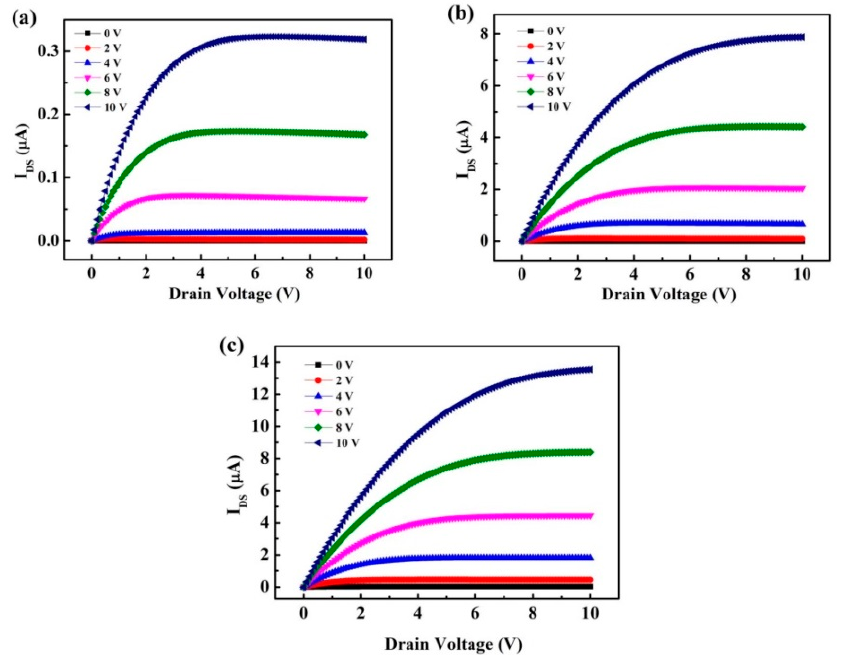
Figure 6. Output characteristics of IGO TFTs with different deposition power of In 2 O 3 . ( a ) Sample A: 50 W, ( b ) sample B: 60 W, and ( c ) sample C: 70 W. Table 1. Electrical performance parameters of IGO TFTs at different deposition power of In 2 O 3 target. I on /I off Ratio S.S (V/dec) µ FE (cm 2 /Vs) V TH (V) Sample A 4.3 × 10 5 0.526 0.4 3.7 Sample B 4.5 × 10 6 3.82 1.45 1.1 Sample C 4 × 10 4 8.3 2.26